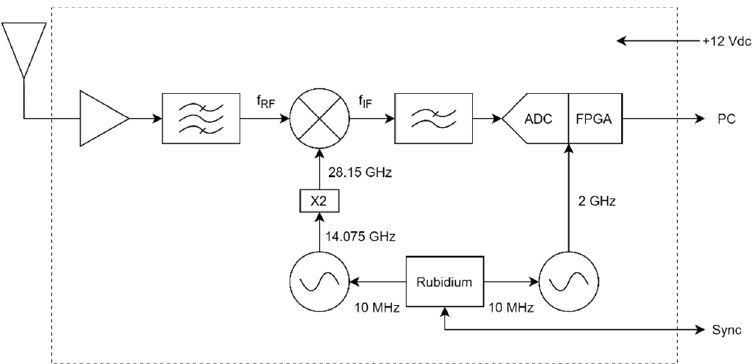
Figure 4. Diagram of the receiver. Table 2. Hardware components of the receiver.